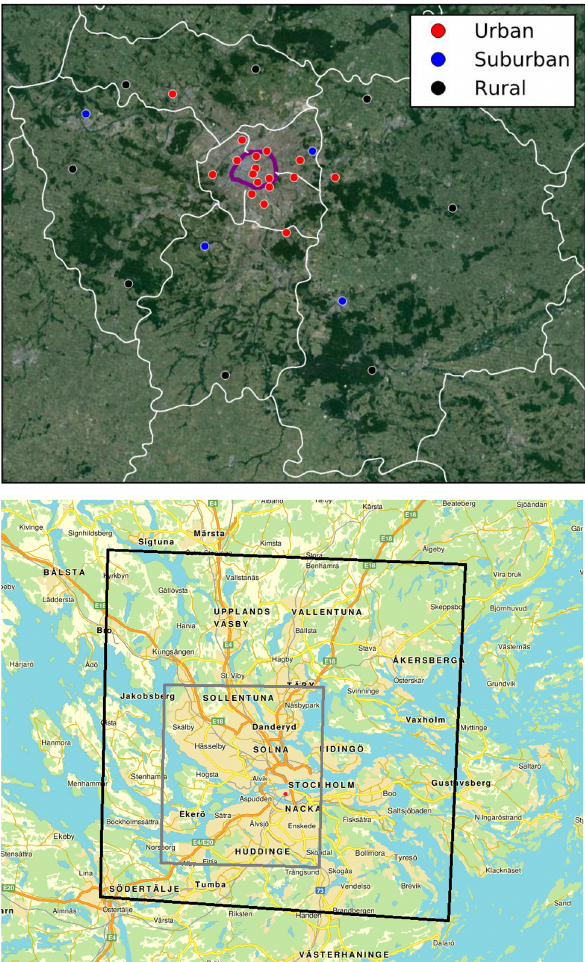
Figure 1. Top panel illustrates the IdF 4km resolution modelling domain, with the city of Paris in the centre (area enclosed by the purple line). Circles correspond to sites of the local air quality mon- itoring network (AIRPARIF) with red for urban, blue for suburban and black for rural. Bottom panel represents the Stockholm 1km resolution modelling domain (black outline) with the urban area en- closed in the grey rectangle. The red circle corresponds to the urban monitoring